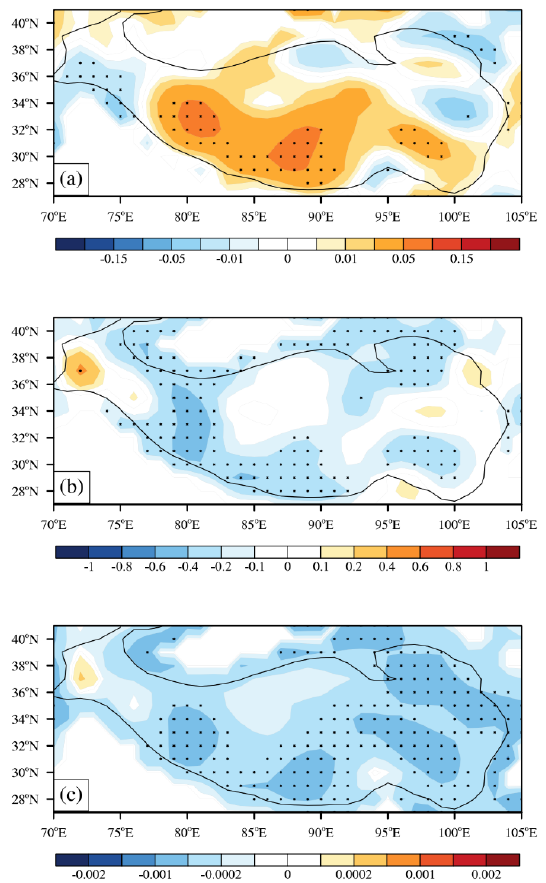
Figure 6. Annual trends of the ( a ) 10-m wind speed (units: m s − 1 decade − 1 ), ( b ) buoyancy frequency (units: 10 − 4 s − 1 decade − 1 ) and ( c ) air density (units: kg m − 3 decade − 1 ) at the surface over the TP during 1979–2017. The black contour denotes the isoline of 3000-m elevation. The dots indicate significant trends at 95% confidence level using the student- t test.